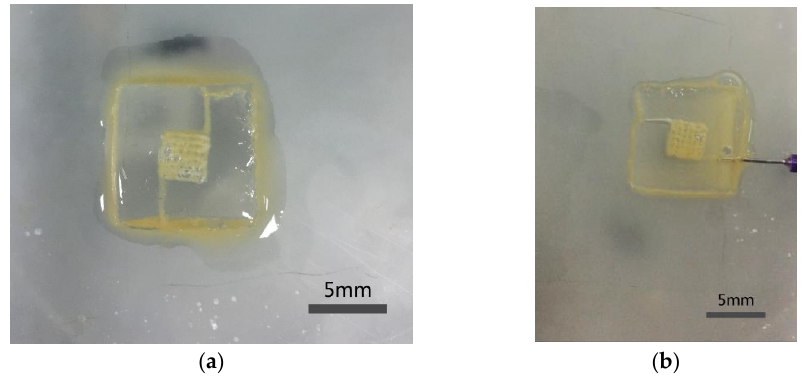
Figure 5. The connectivity experiment of construct. ( a ) The connectivity of macrochannels ( b ) the connectivity of multiscale channels. Scale bar is 5 mm.